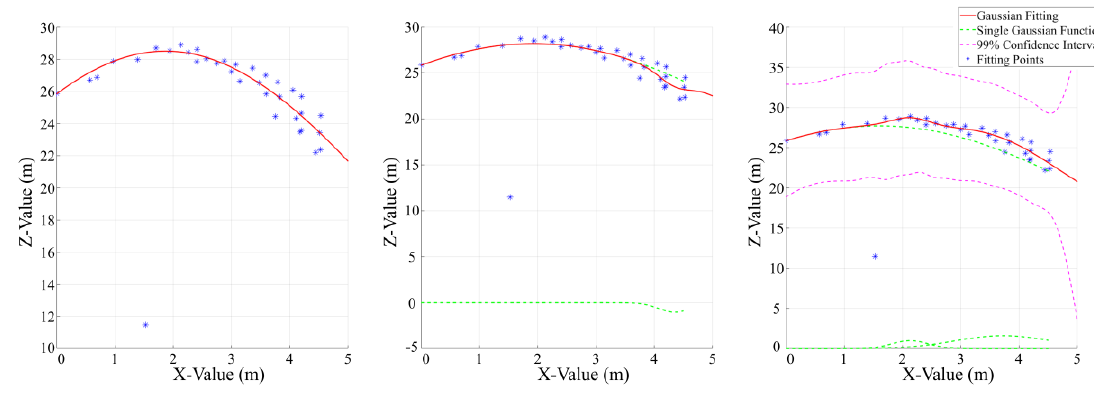
Figure 6. Gaussian fitting of three selected profiles, with the number of functions increasing from one to three. The figures show the upper canopy points as a blue asterisk, the combined model as a red line, and the model components using the single function as green imaginary lines. The magenta imaginary lines are the 99% confidence interval of the Gaussian fitting model.